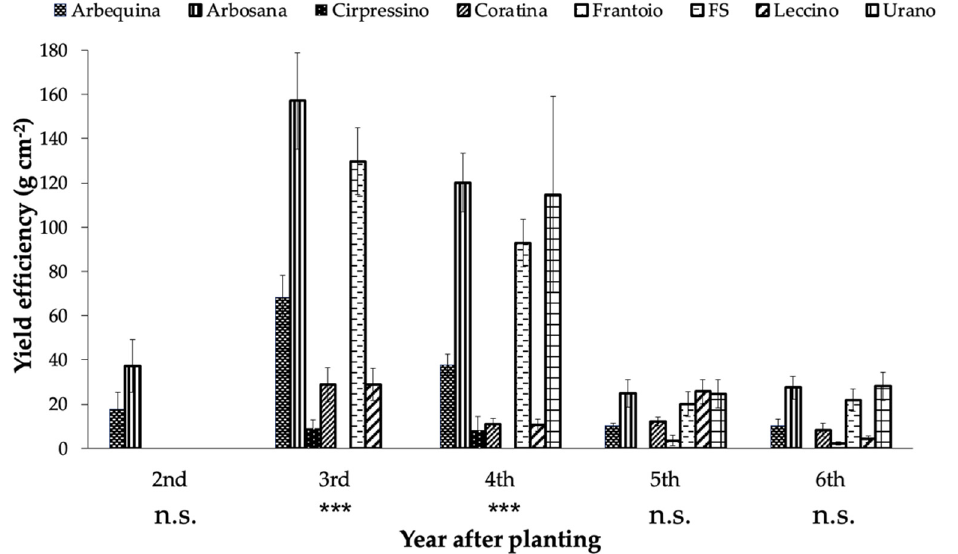
Figure 5. Effect of cultivar on yield efficiency (YE, g cm − 2 ) for each year. Standard error (SE) of the mean difference and least significant difference (LSD) ( p < 0.001) are reported. *** means p < 0.001. n.s. means no significance.